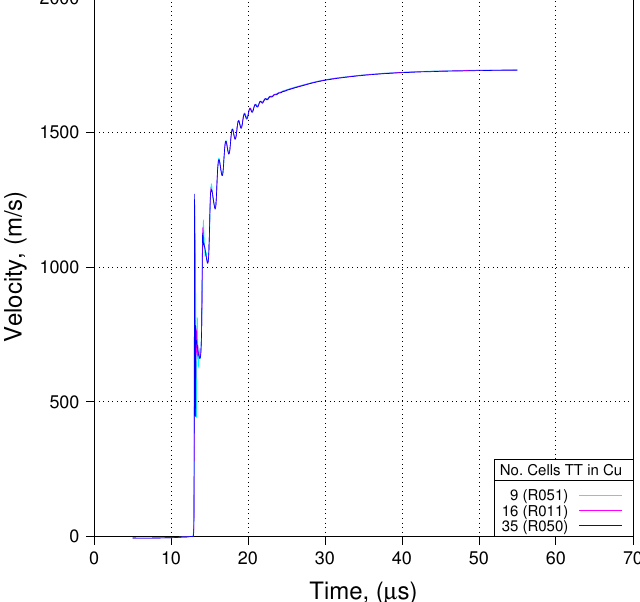
Figure 9. Impedance matching is unnecessary (PDV traces Probe